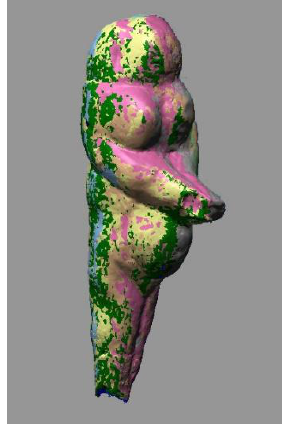
Table 1. Parameters about the artefact dimensions, the photographic acquisition and the point cloud